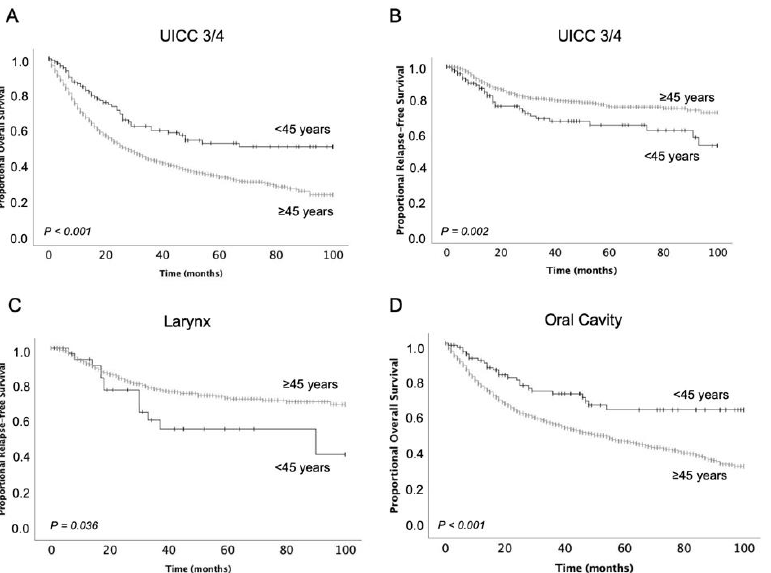
Figure 2. Overall survival ( A ) for advanced disease stages and tumors localized at the oral cavity ( D ) and relapse-free survival for advanced disease stages ( B ) and tumors localized at the larynx ( C ) in patients aged under 45 years in comparison to older patients.